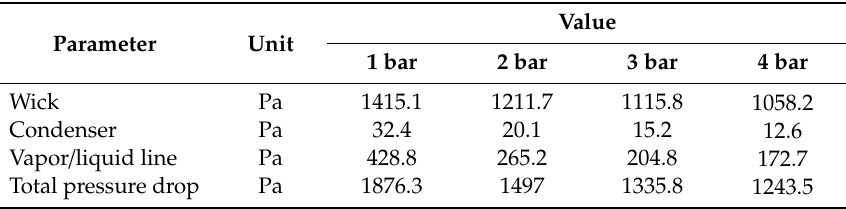
Table 6. Total pressure drop in the CLHP.